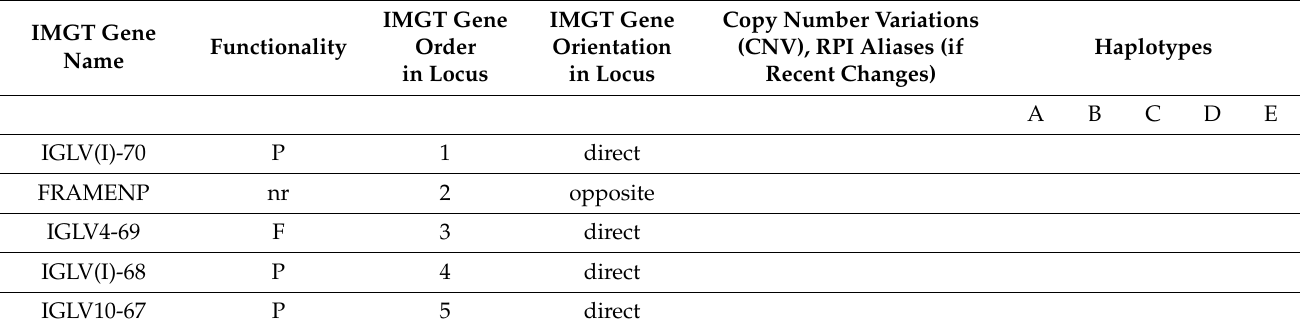
Table 6. Homo sapiens IGL locus: IMGT gene order, copy number variations (CNV) and haplotypes. IMGT